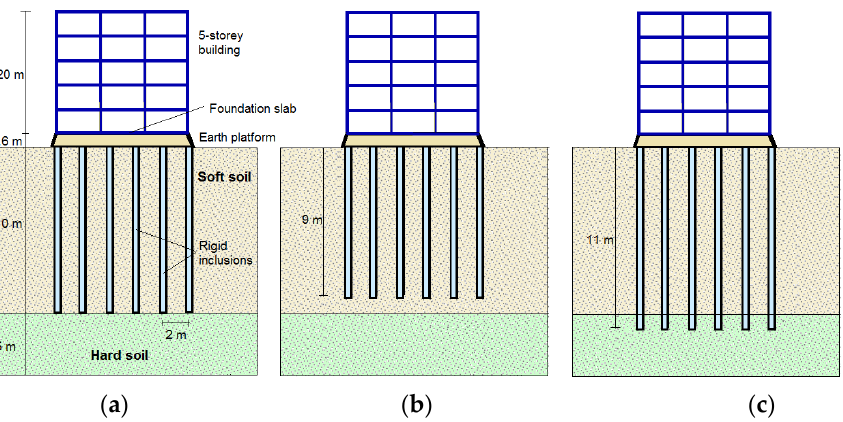
Figure 6. Nice 2001 earthquake. ( a ) Earthquake record; ( b ) Fourier amplitude and acceleration response spectrum.